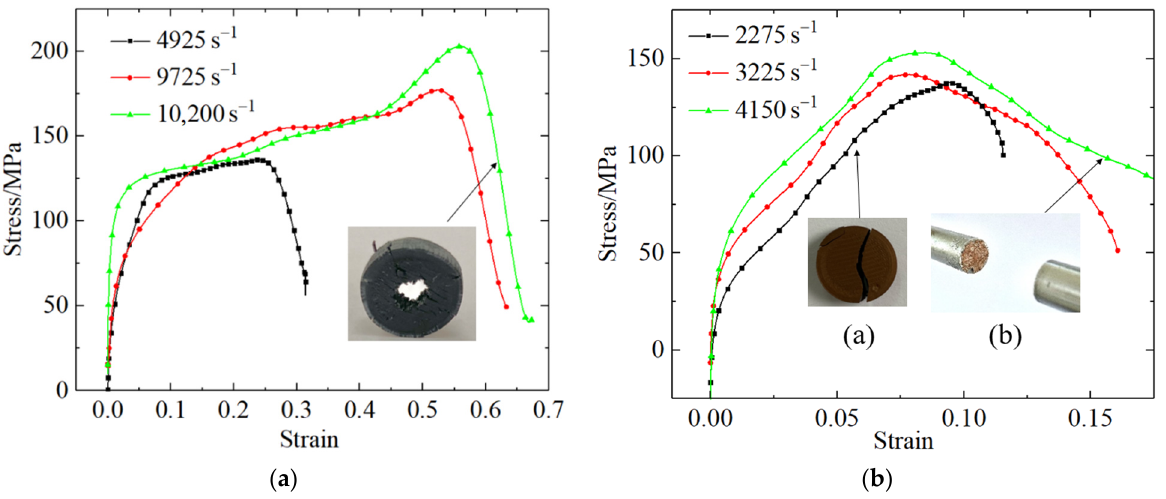
Figure 5. Dynamic stress-strain curves of ( a ) PLA; ( b ) PLA-Cu.